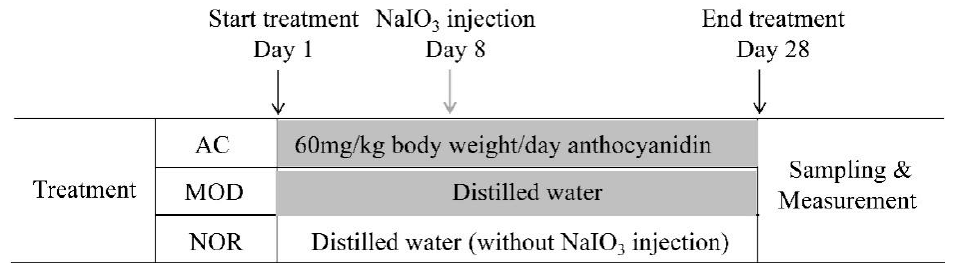
Figure 1. Schematic diagram for the treatment of rats with NaIO 3 and aronia fruit extract. Thirty-six SD rats were randomly separated into three groups (NOR, MOD, and AC), twelve rats each group. NOR: control without treatment; MOD: damage model by 30 mg/kg body weight NaIO 3 tail vein injection; AC: anthocyanidin (60 mg/kg body weight) treatment of the damage model.